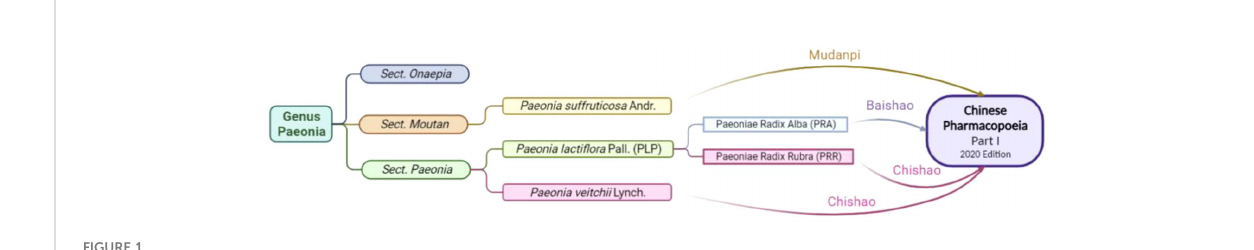
FIGURE 1 Botanical origin and inclusion in the Chinese Pharmacopoeia of Paeonia. Created in BioRender.com.